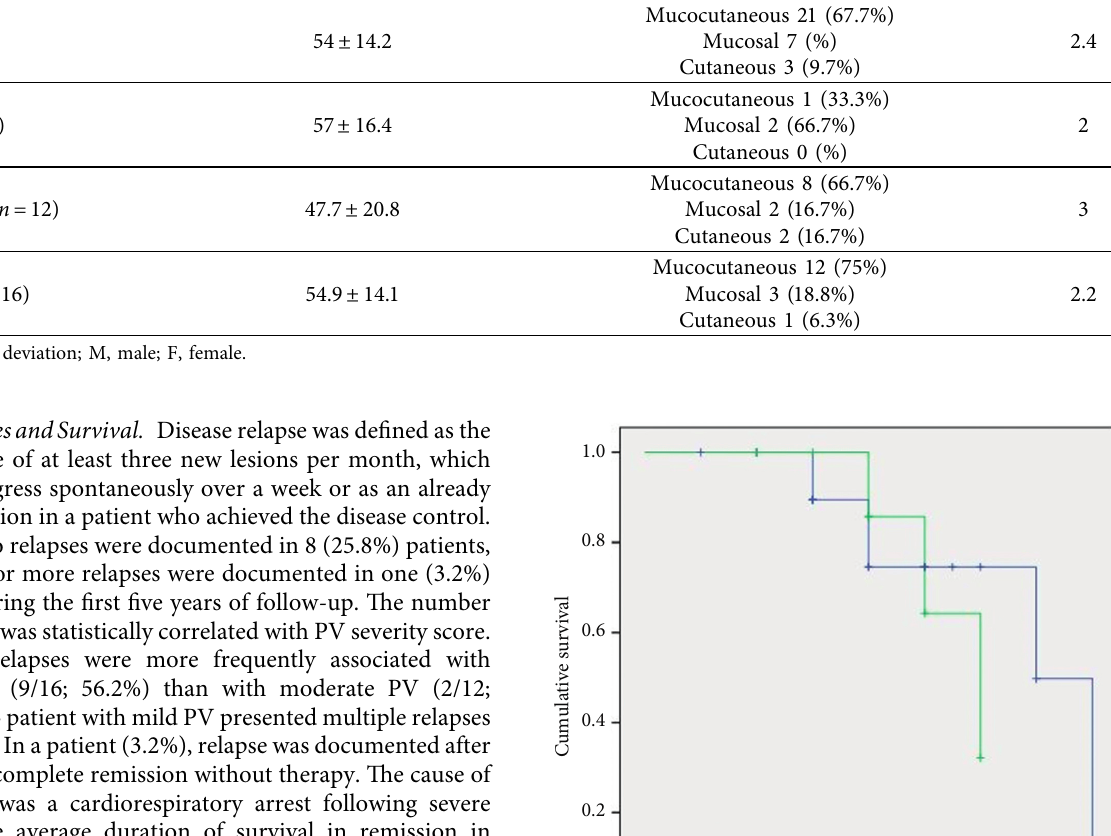
Table 1: Characteristics of patients: age at onset, sex, and phenotype of pemphigus vulgaris (PV). Patients